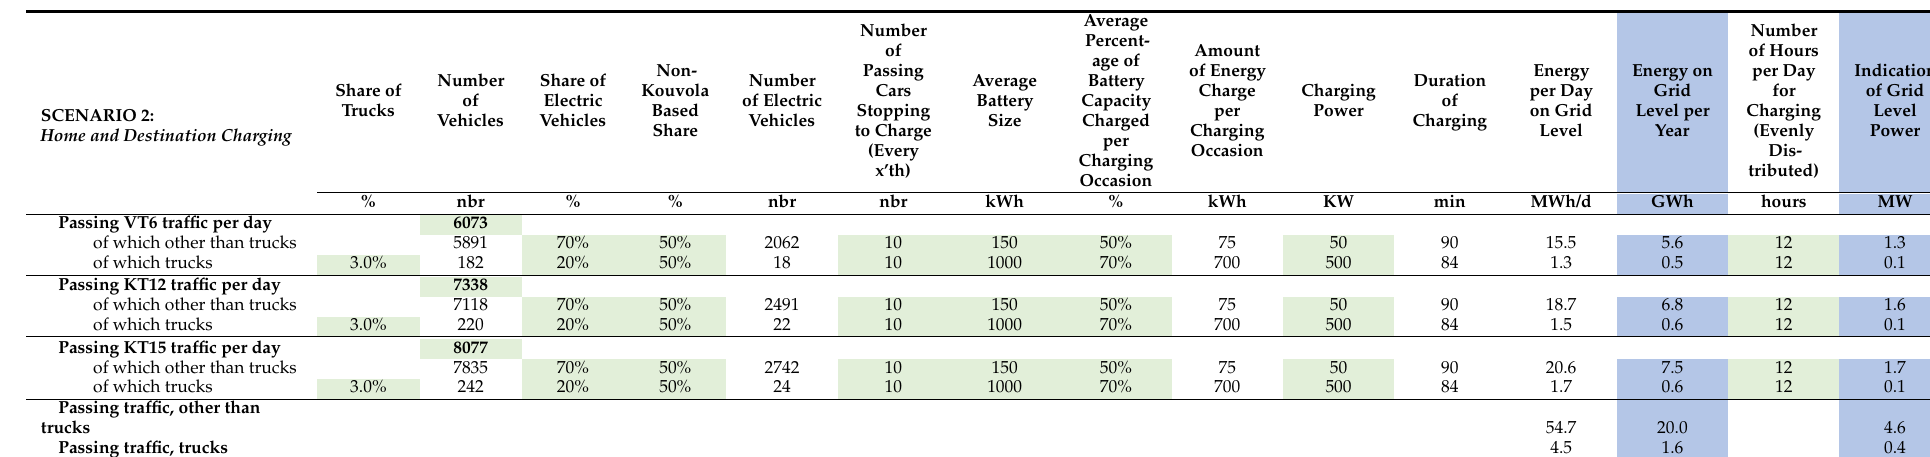
Table A6. Detailed quantification of passing traffic (the derived additional energy is consolidated into the summary (Table A4) and subdivided into user groups in Table